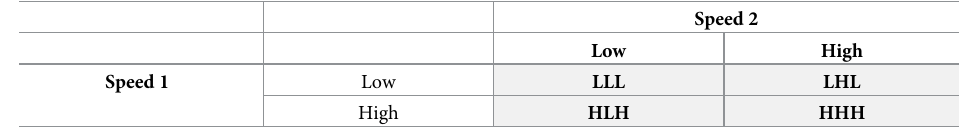
Table 2. The four transfer ABA